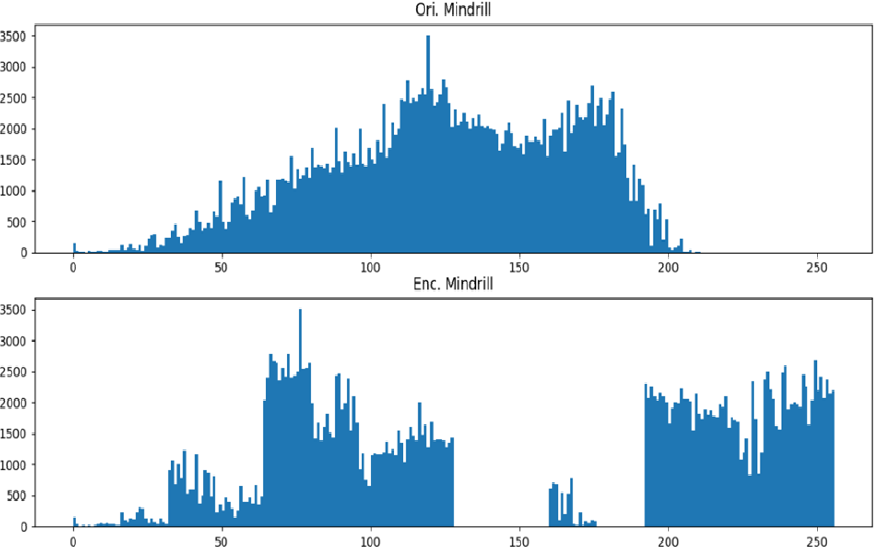
Figure 7. Histogram of Mandrill test image. On top Mandrill before scrambling and on bottom Mandrill after scrambling.